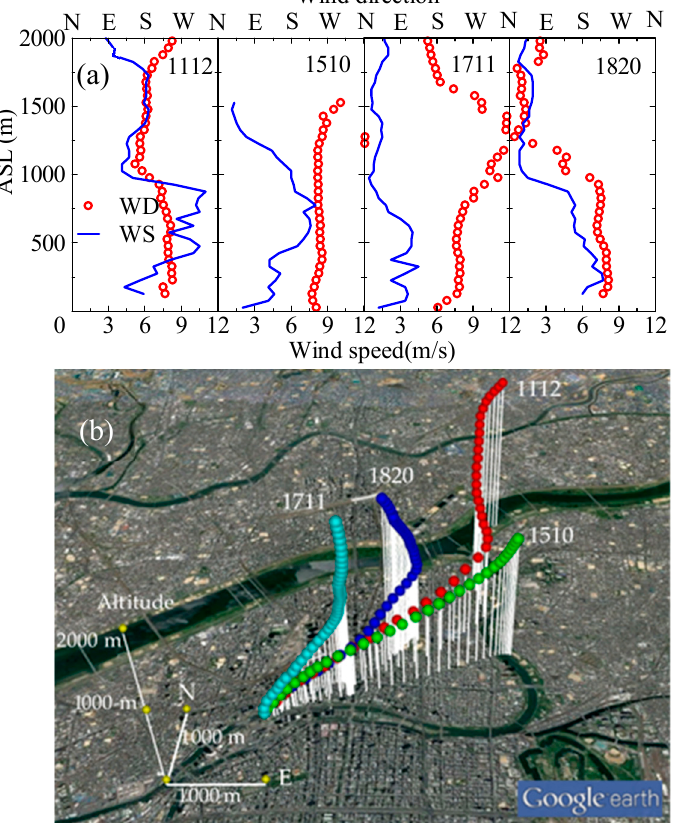
Figure 11. Upper wind around the study area on 31 August 2010. ( a ) Vertical profiles of the horizontal winds. The numbers in the figures are starting time (hhmm LST) of the observations. ( b ) Three-dimensional trajectories of the pilot balloons. The circular mark indicates balloon position of every 20 s (vertical interval is approx. 50 m). The starting time of each observation is shown near the end point of the trajectory.